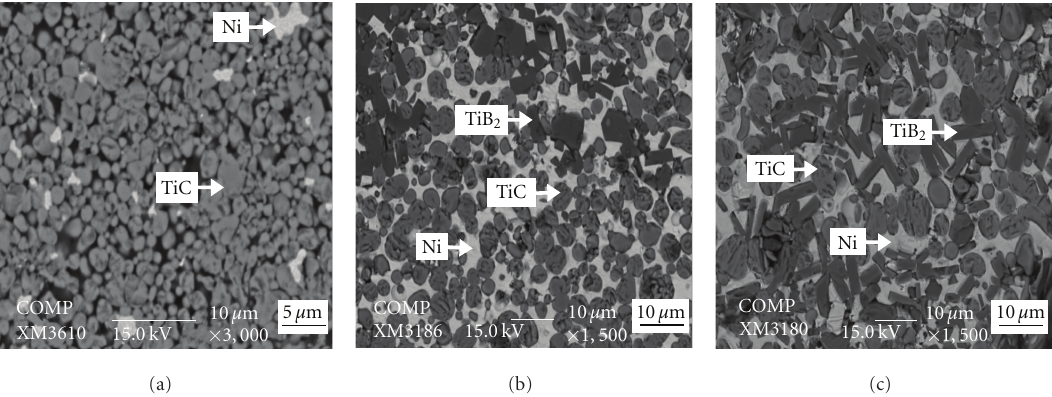
Figure 5: SEM photographs of samples with 20vol% Ni and di ff erent volume fraction of TiC and/or TiB 2 . (a) TiC-Ni(80/20), (b) TiC-TiB 2 - Ni(60/20/20), and (c) TiC-TiB 2 -Ni(40/40/20).